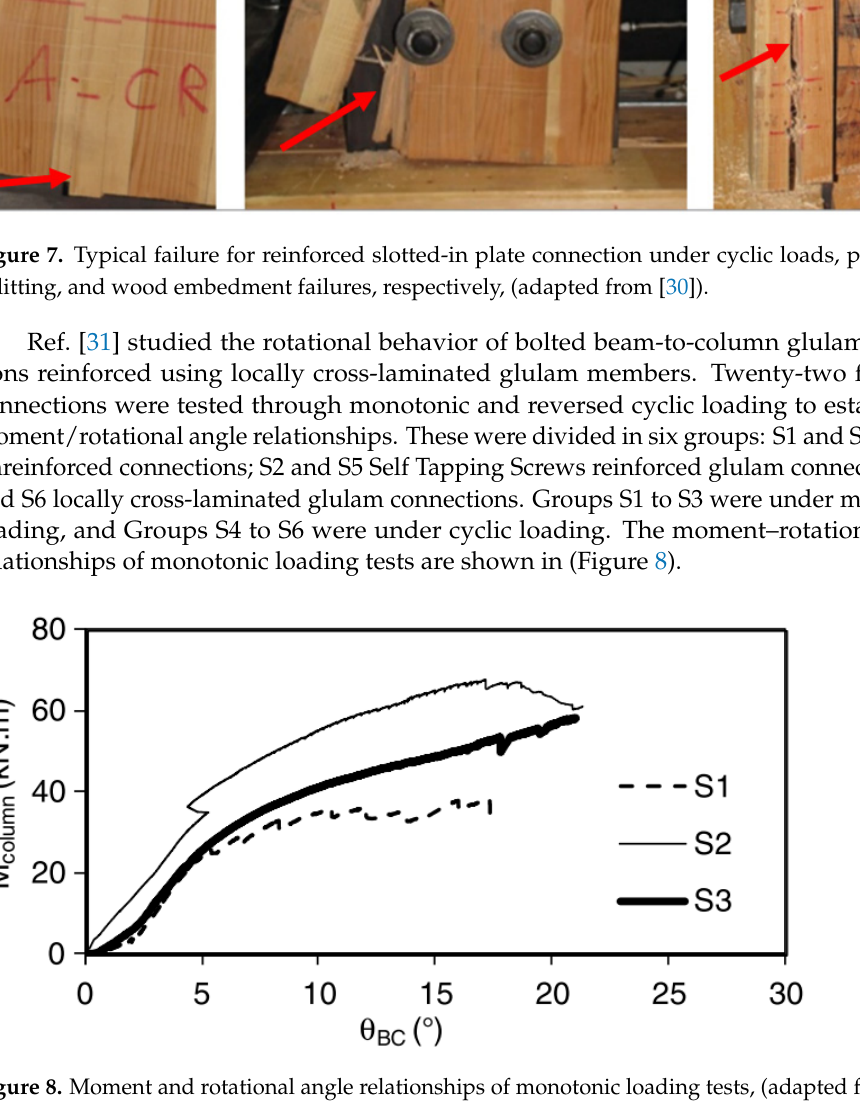
Figure 8. Moment and rotational angle relationships of monotonic loading tests, adapted from